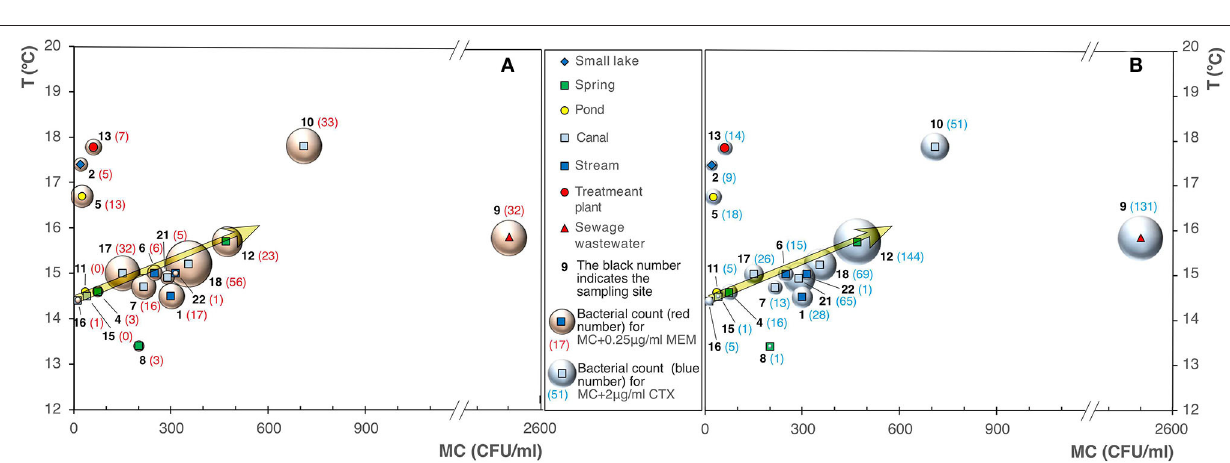
FIGURE 4 | Bubble diagrams of bacterial counts on MacConkey (MC) vs. water temperature. (A) MC with addition of 0.25 µ g/ml of meropenem (MEM); (B) with addition of 2 µ g/ml of cefotaxime